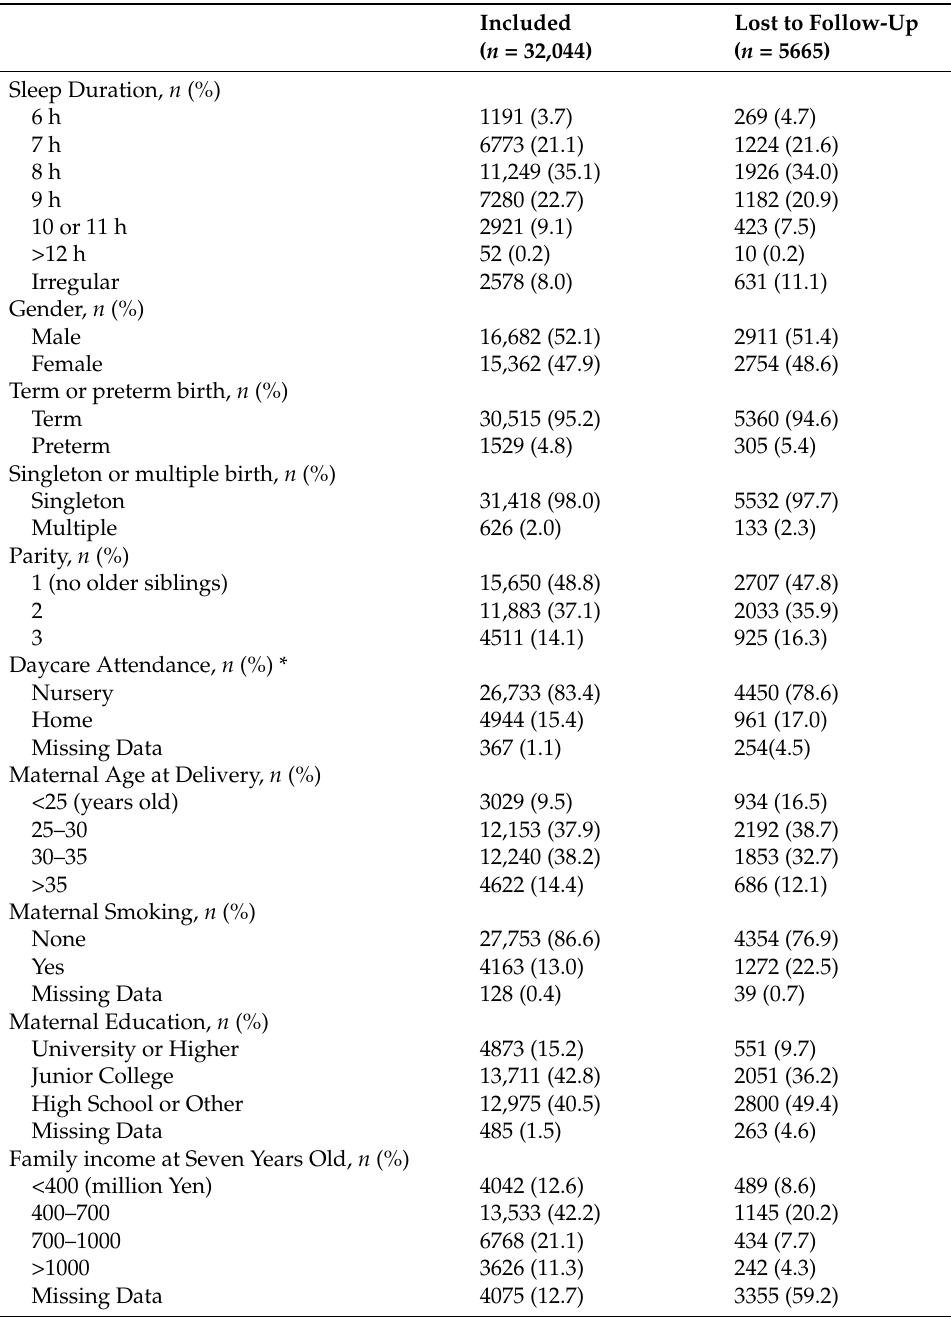
Table 1. Characteristics of children included in the study and lost to follow-up at 5.5–9 years old ( n =